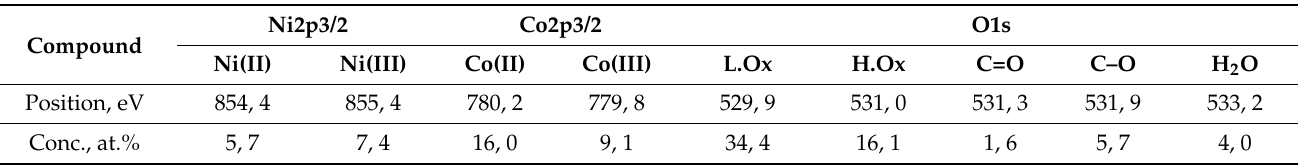
Table 3. Concentrations and positions of the